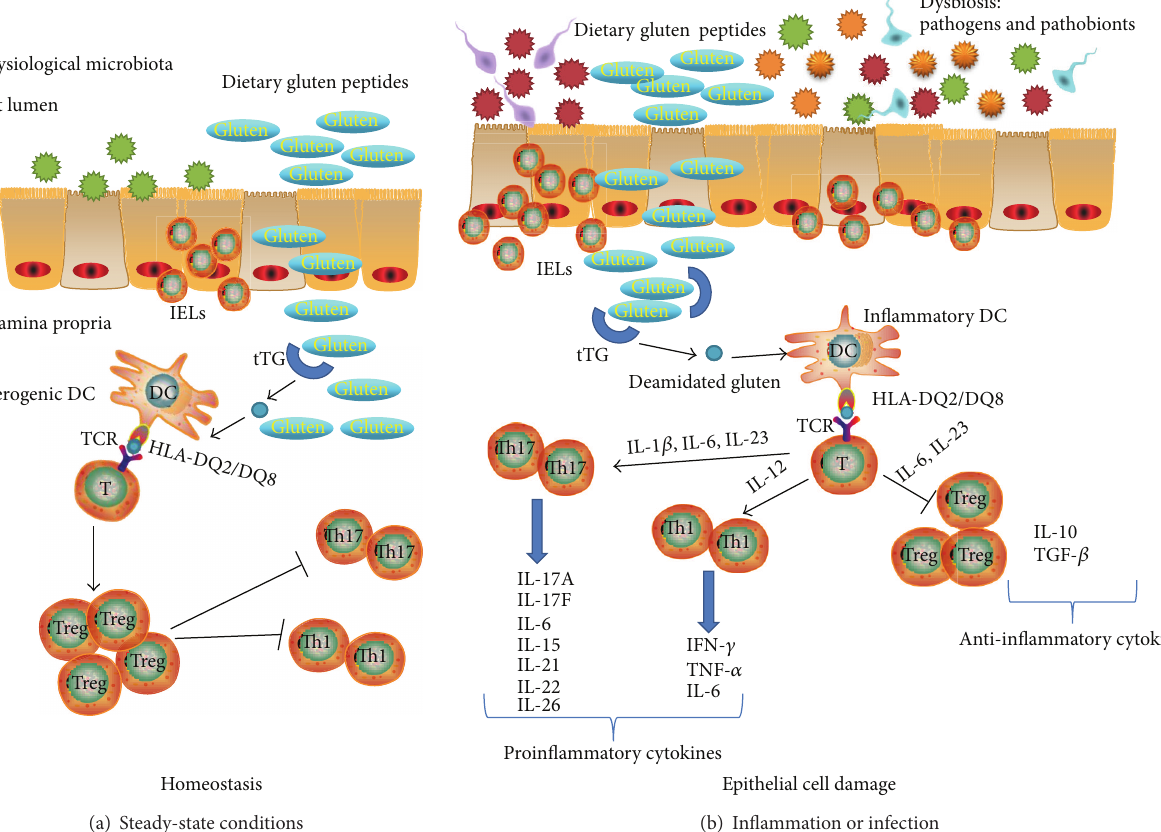
Figure 1: The complex interconnection among immune system, microbiota, and environmental factors (including dietary food antigens and/orinfection)inthepathogenesisofceliacdisease.(a)Steady-statecondition.Dietaryantigensandphysiologicmicrobiotaareinsymbiotic relationship with host mucosal cells; thereby a harmonized balance between pro- and anti-inflammatory factors is achieved (homeostasis). (b) Inflammation or infection. The breakdown of the normal microbial community contributes to dysbiosis. In CD patients, gluten derived peptidesarerecognizedbyantigenpresentingcells,withT-cellsresponse.DeaminatedglutenpeptidesarepresentedtoT-cellswithsubsequent release of proinflammatory cytokines. In this way, Tregs are suppressed. This fact leads to a break of balance with consequent epithelial cell